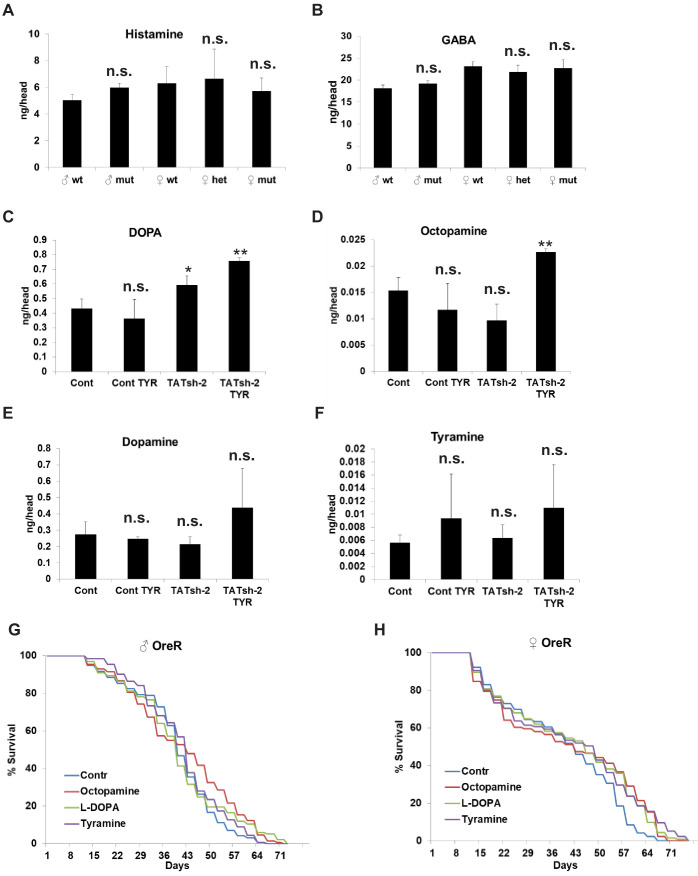
Neuronal-specific downregulation of Tyrosine Aminotransferase/TAT increases levels of tyrosine-derived neurotransmitters.Head levels of Histamine (A) and GABA (B) in CG1461/TAT wild-type (wt), heterozygous (het), and mutant (mut) flies. Head levels of DOPA (C), Octopamine (D), Dopamine (E), Tyramine (F) in elav-Gal4, tubulin-Gal80ts > control RNAi or TAT RNAi flies maintained either on the regular food or the food containing 5 mM of tyrosine for 2 days. Means ± SD. *p<0.05, **p<0.01, ***p<0.001. Feeding adult male (G) and female (H) OreR flies with 5 mM Octopamine, L-DOPA, or Tyramine starting day 14.